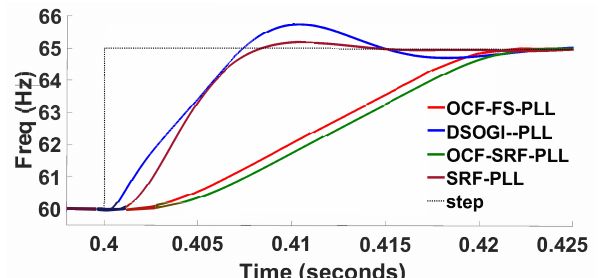
Figure 21. The frequency of the grid voltage with frequency